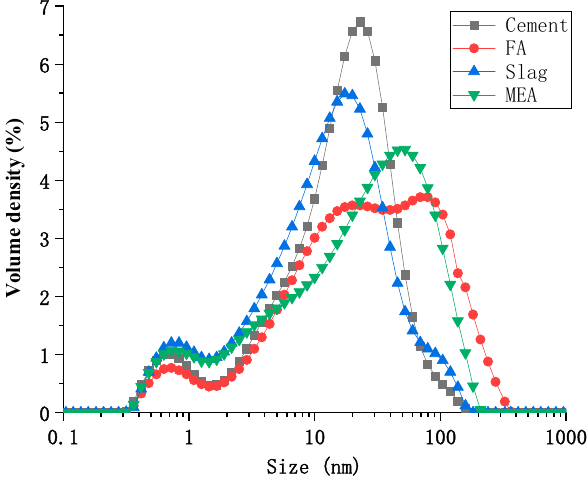
Figure 1. The particle size distribution curves of the materials.